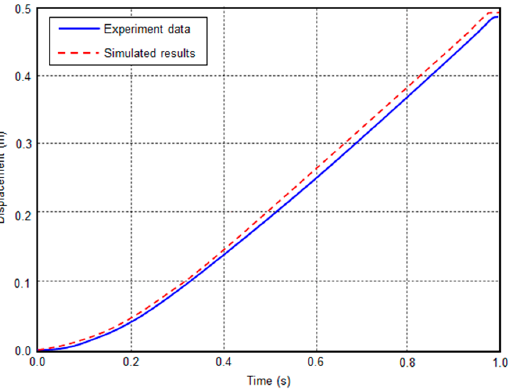
Figure 6. Comparison between the numerical and experimental vertical displacement time history of the rigid block.